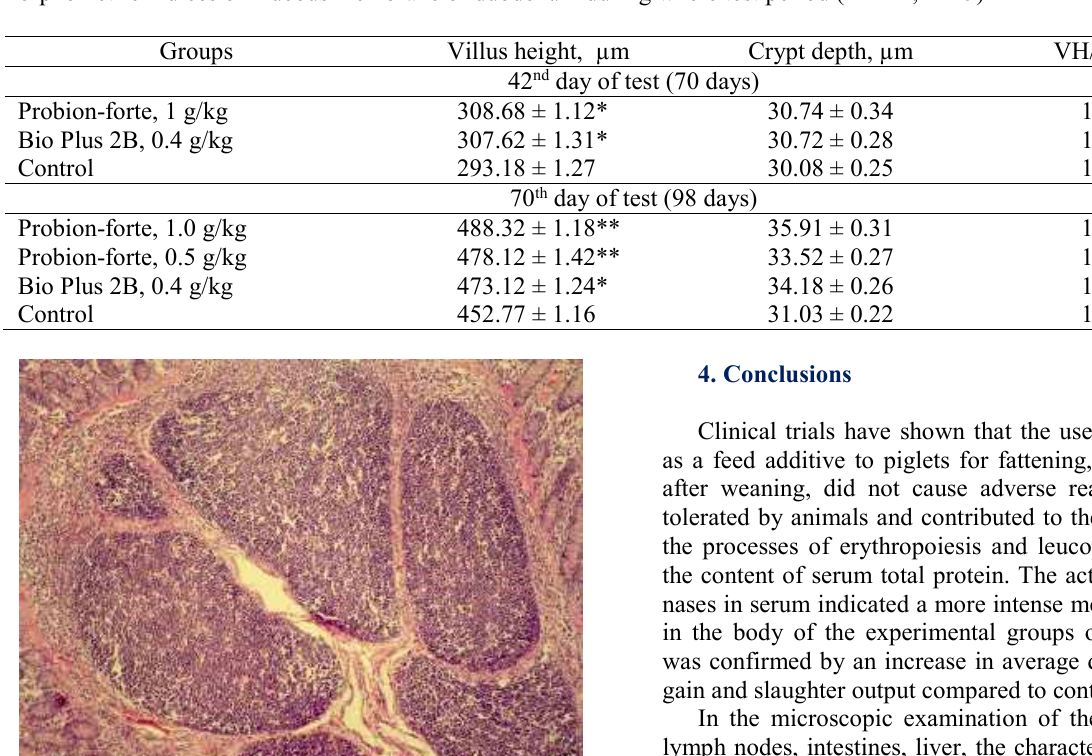
Table 5 Morphometric indices of mucous membrane of duodenum during whole test period (М ± m, n = 5)